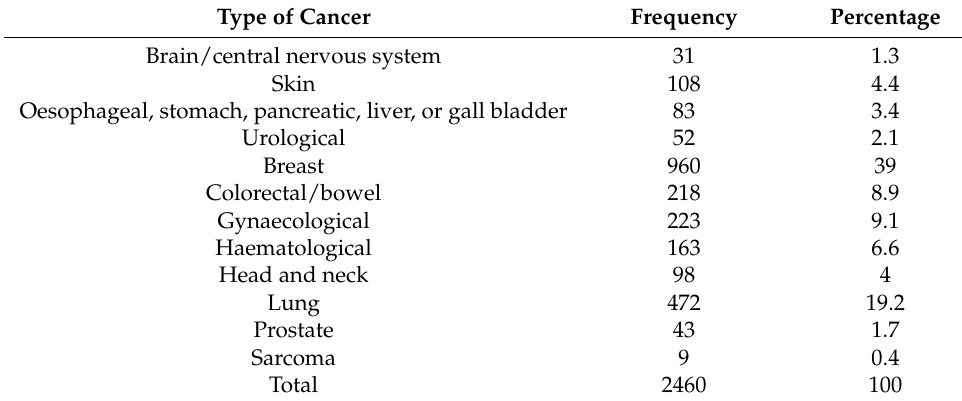
Table 1. Frequency distribution according to the type of cancer. Type of Cancer Frequency Percentage Brain/central nervous system 31 1.3 Skin 108